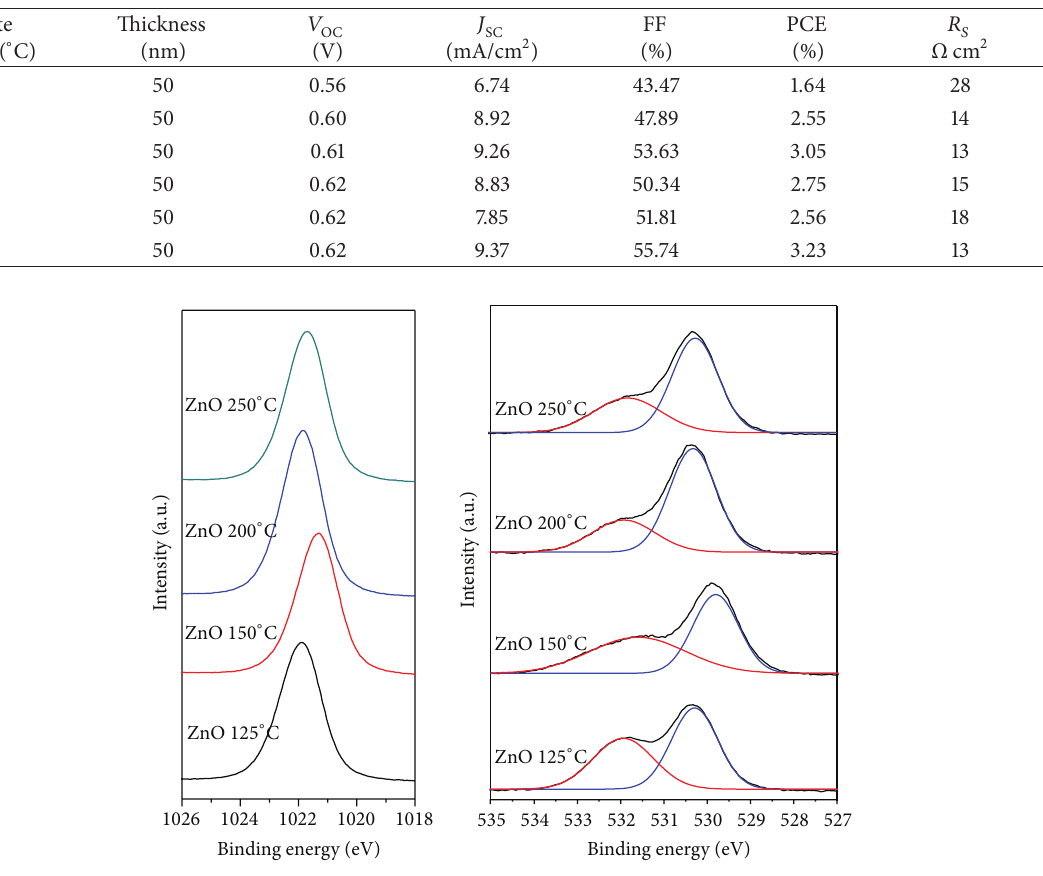
Table 1: Device characteristics of PSCs prepared at different substrate temperatures.